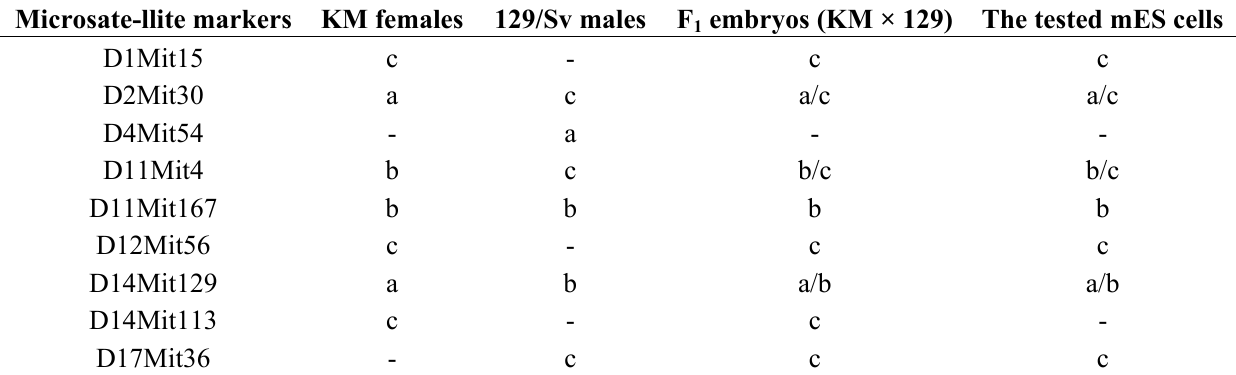
Table 5. Genotype analysis of the established mES cells by microsatellite marker-based PCR.